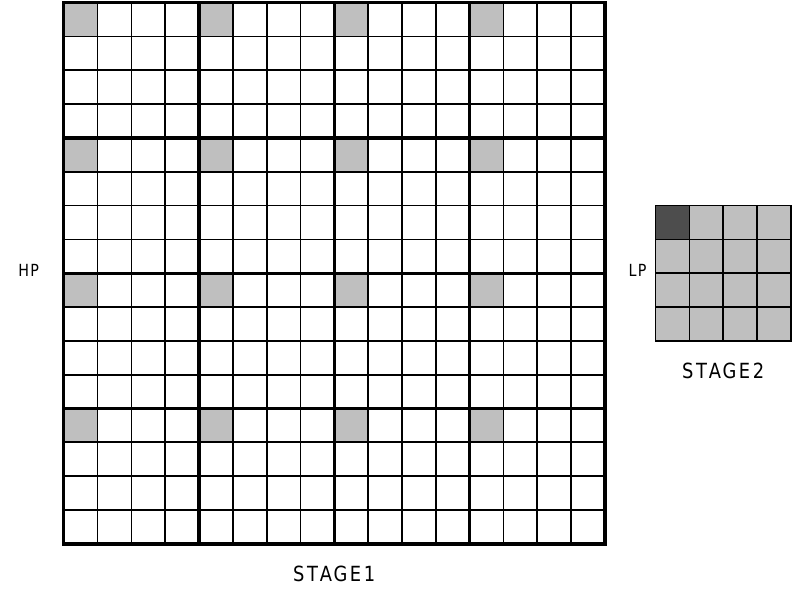
Figure 15. Two-stage PCT in